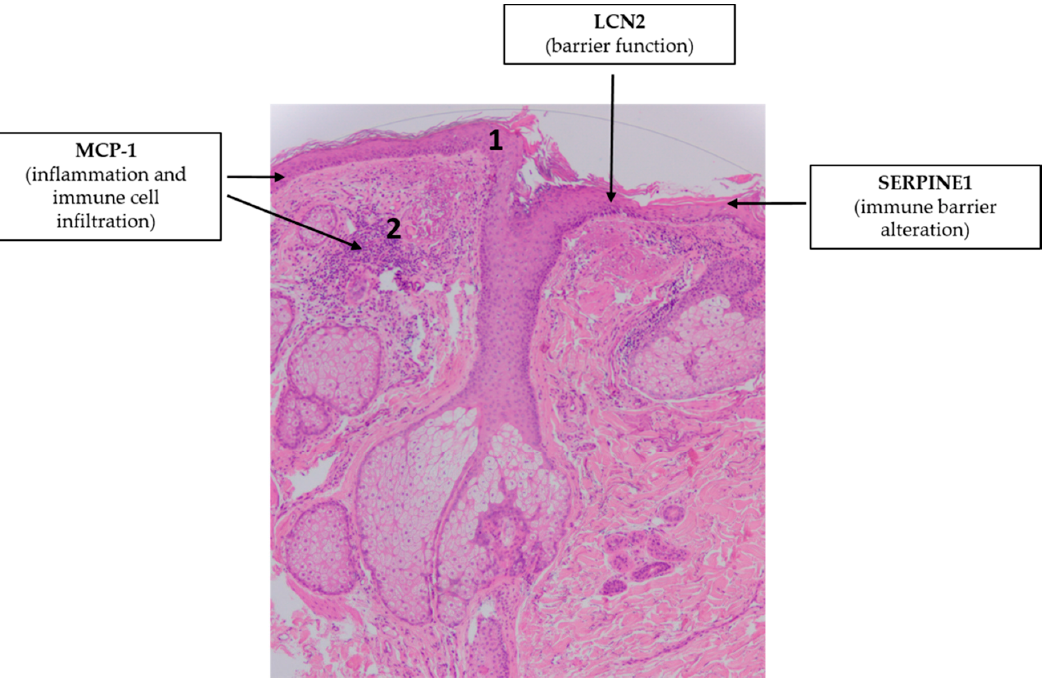
Figure 5. Adipokines may be involved in the pathogenesis of rosacea. Note the simplified characteristic histopathological findings in rosacea: impaired barrier function (1), interfollicular inflammation in the dermis (2). Hematoxylin eosin staining; original magnification: 50×.